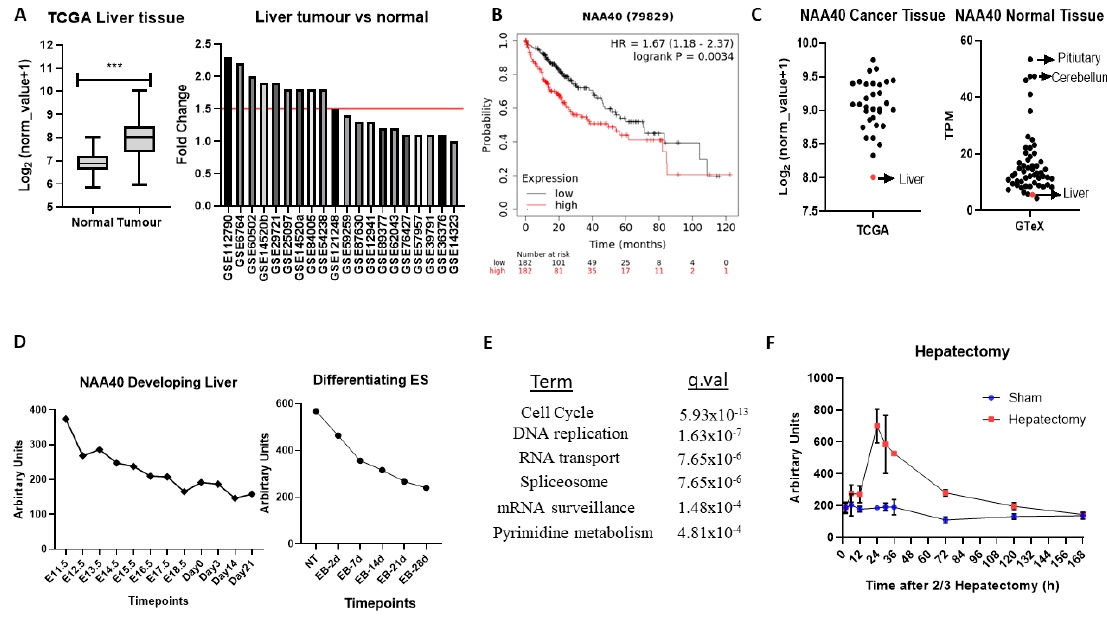
Figure 5. NAA40 is associated with liver proliferation and cancer. ( A ) NAA40 transcript comparison between normal and tumour liver tissue in TCGA (left panel) and 20 studies from GEO omnibus (right panel); ( B ) KM plot for liver cancer, with samples divided according to median NAA40 expression; ( C ) Transcript levels of NAA40 in TCGA pan-cancer (left panel) and GTeX study (right panel). Each circle represents mean transcript value of one tissue type, with arrow indicating relative levels of liver; ( D ) Timecourse of NAA40 transcript levels in developing liver (left panel) and in Embryonic Stem (ES) cells differentiating to hepatocytes (right panel); ( E ) KEGG enriched terms among 1000 top co-expressed genes in 107 liver cancer datasets ( q < 0.001); ( F ) Time course of NAA40 transcript levels in regenerating liver following 2/3 hepatectomy. *** p <0.001 Student’s t-test.